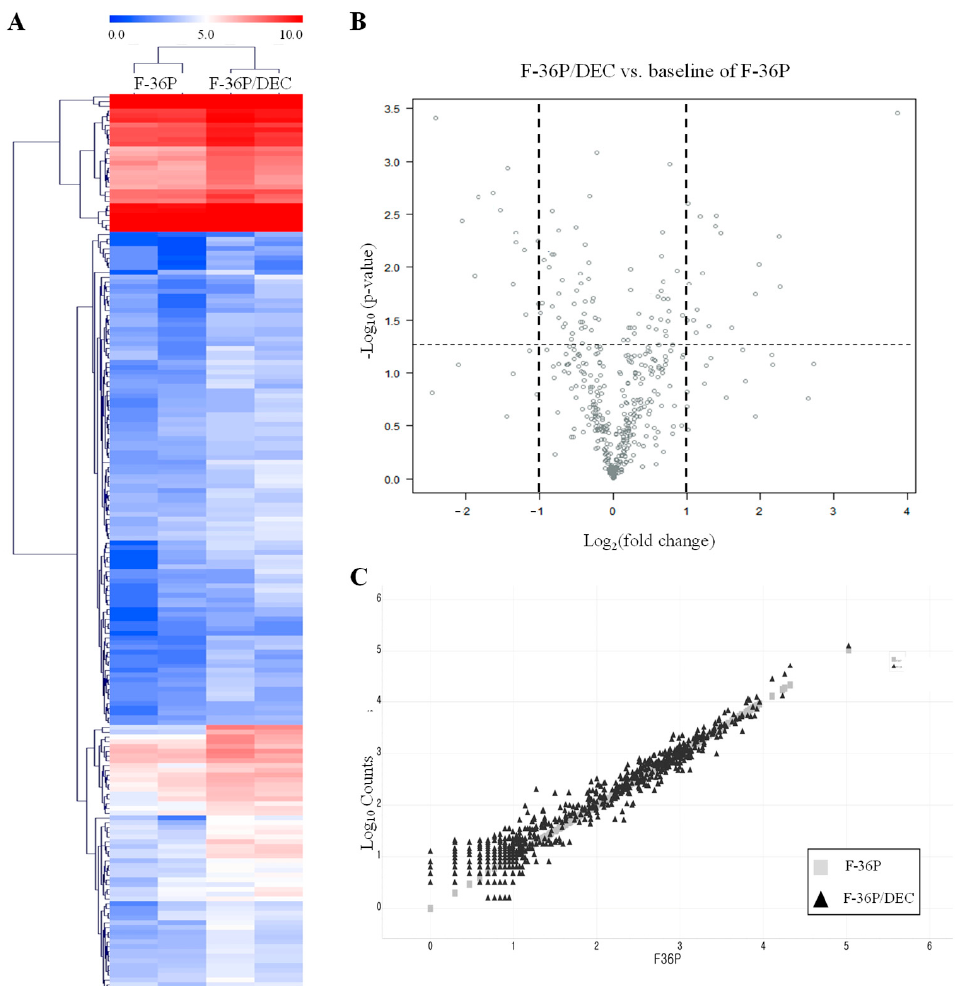
Figure 2. Analysis of DEGs between F-36P/DEC and F-36P cells. ( A ) Heatmap illustrates significant DEGs between F-36P cells and F-36P/DEC cells. Representations of genes were processed using the general linear model likelihood ratio test ( p < 0.05 and absolute log 2 fold change > 1). ( B ) Significant DEGs between F-36P cells and F-36P/DEC cells, in the form of log 10 ( p -value) versus log 2 (fold change), are presented graphically as volcano plots. The horizontal lines indicate statistical significance at p < 0.05. ( C ) Scatter plot of DEGs in F-36P/DEC cells compared with those in F-36P cells. DEGs were selected on the basis of (logFC) ≥ 1.5 and p <